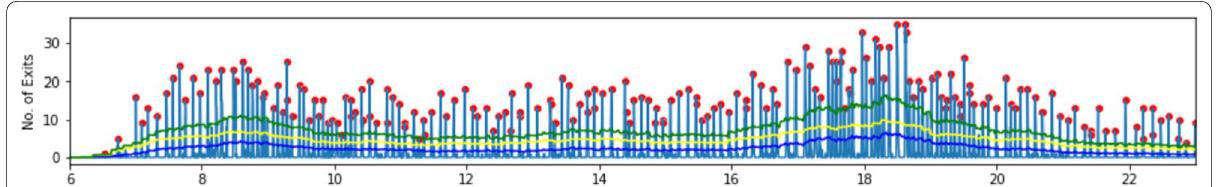
Fig. 2 Volume of passengers over time for October 7 in Santa Apolónia station. Red dots show spikes in passenger volume, blue line shows the rolling mean, yellow line shows the rolling standard deviation, and green line shows one standard deviation away from the rolling mean